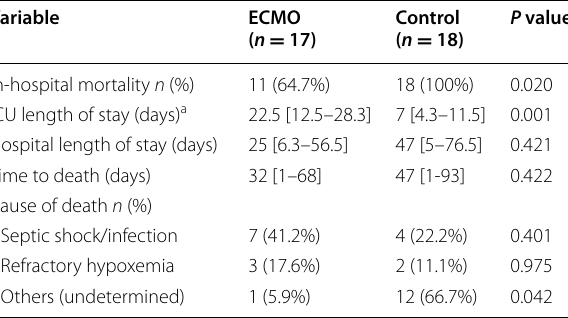
Data are presented as number (%), mean (SD), or median [minimum–maximum] a